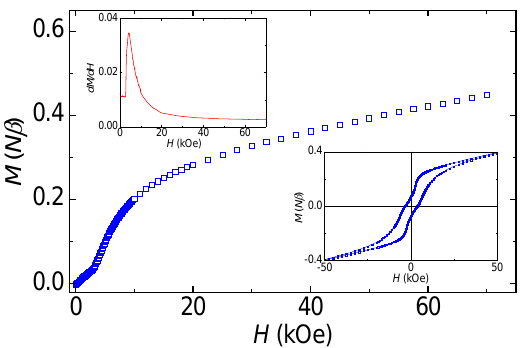
Figure 7. Field dependence of the magnetization of 2 at 2.0 K. The insets give the derivation of M vs. H and a blow-up of the hysteresis loop.